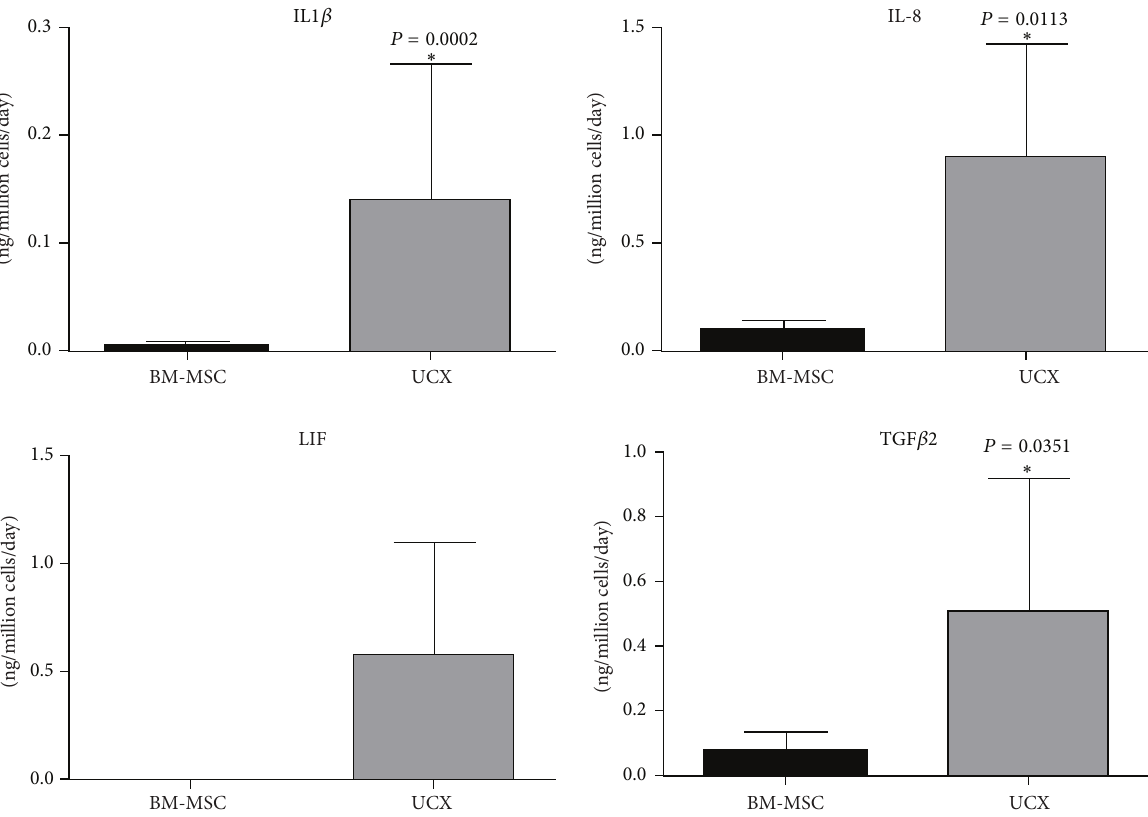
Figure 7: Quantification of IL-1 𝛽 , IL-8, LIF, and TGF- 𝛽 2 in conditioned media from UCX and BM-MSCs. Except for IL-8 which was quantified using FlowCytomix, all other secreted proteins were quantified by ELISA. Values are represented as mean ± s.e.m. and statistically significant differences are indicated by asterisks (unpaired 𝑡 -test). No statistical analysis was performed in the case of LIF since this protein was not detected in conditioned media from BM-MSCs. All 4 secreted factors were detected in higher amounts in conditioned media obtained from UCX